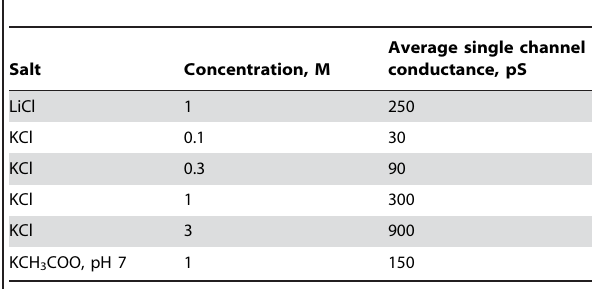
Table 3. Average single channel conductance, G , of the BesC channels in different salt solutions.